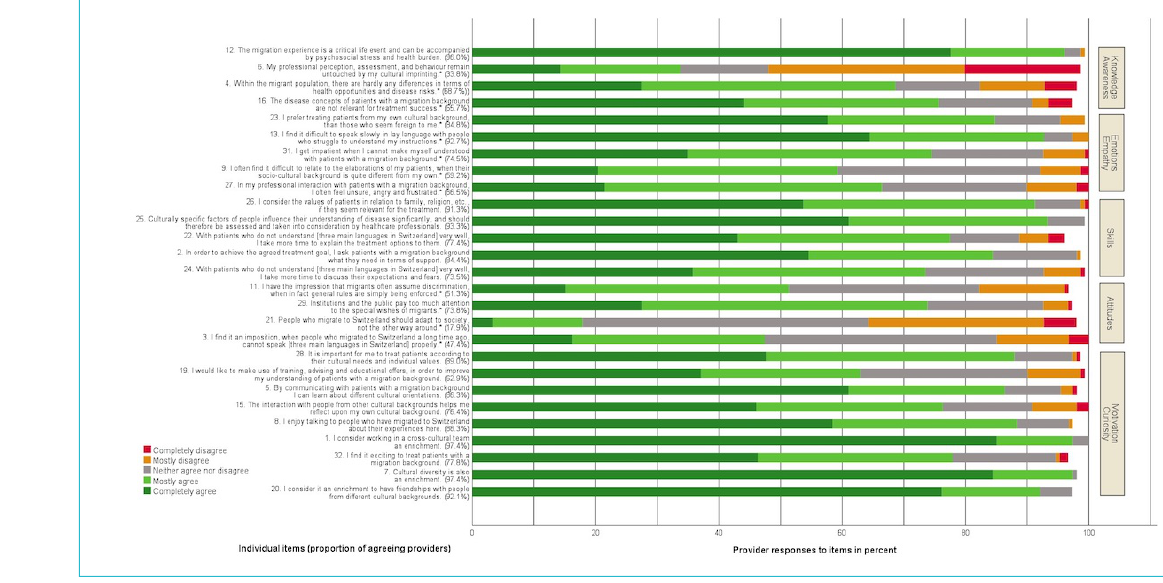
point Likert items) are presented in figure 2. With the ex- ception of one sub-scale (α knowledge/awareness = 0.557), reli- ability of the overall CCCHP scale and the subscales was = 0.728 , α attitudes = 0.690, α skills = 0.680, α emotions/empathy = 0.680).